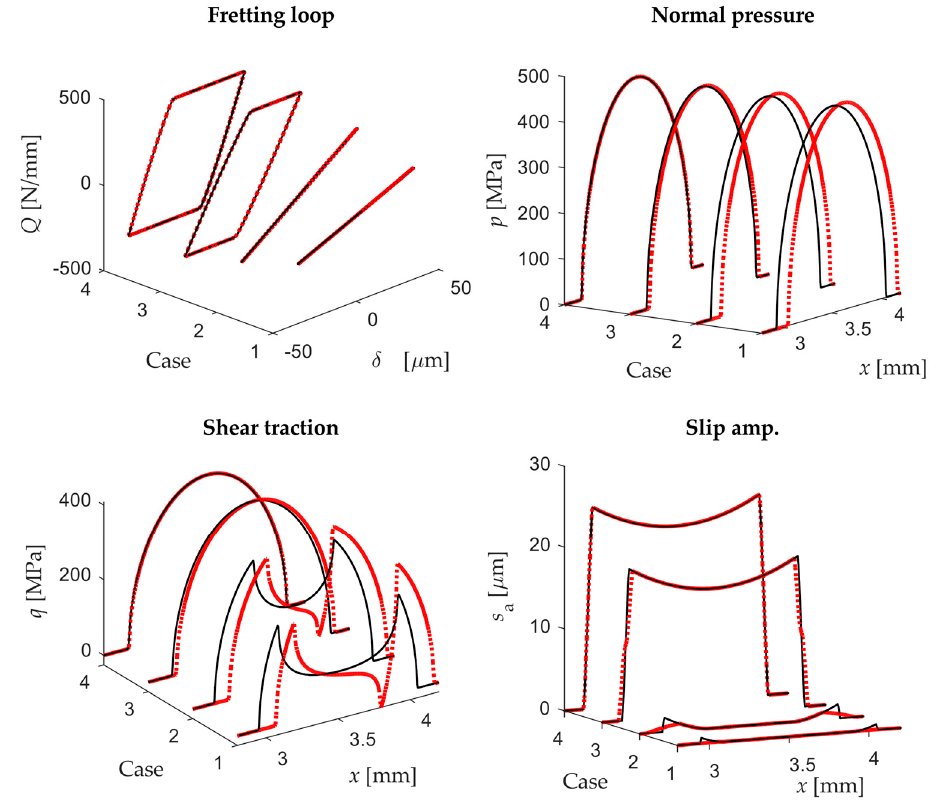
Figure 12. Fretting loops, normal and shear tractions at maximum displacement and slip amplitude along the contact for the four cases analysed with the 1st scenario (black continuous line) and 2nd scenario (red dotted line) using a cyl.-to-flat contact configuration .